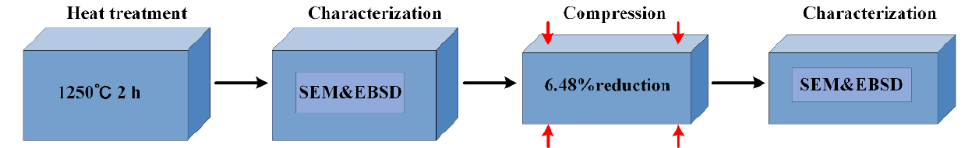
Figure 1. Processing and characterization schedule.